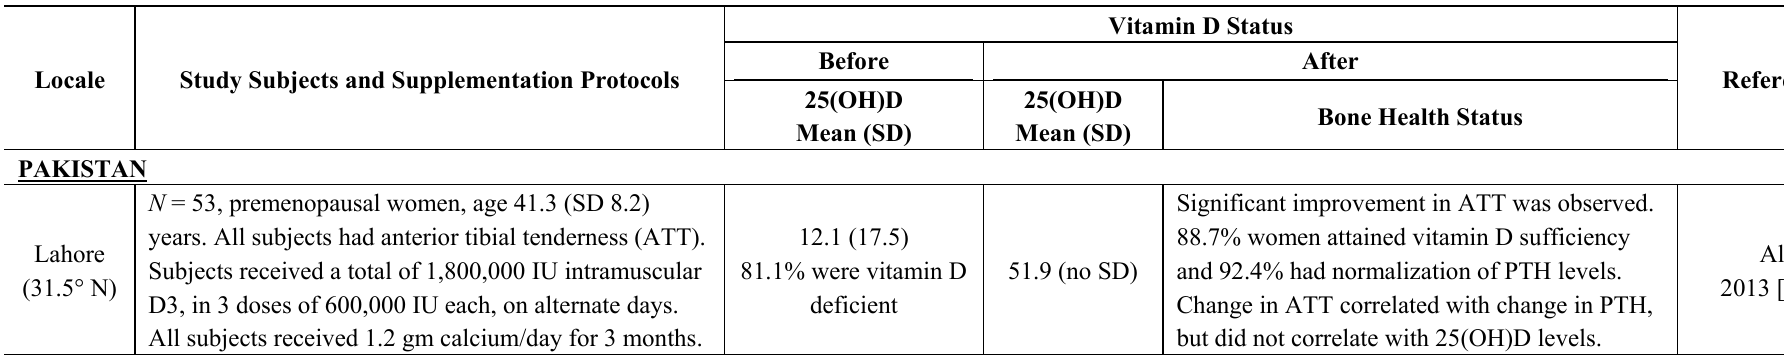
Table 8. Vitamin D supplementation studies reporting improved bone health post-intervention, in ostensibly healthy subjects from other countries of the Indian subcontinent: All 25(OH)D values have been shown in ng/mL. To convert from nM to ng/mL, nM values were divided by (2.5). Vitamin D deficiency is defined as 25(OH)D < 20 ng/mL, insufficiency as 20–29 ng/mL and sufficiency as ≥ 30 ng/mL. D3 is cholecalciferol. Calcium amount mentioned is that of elemental